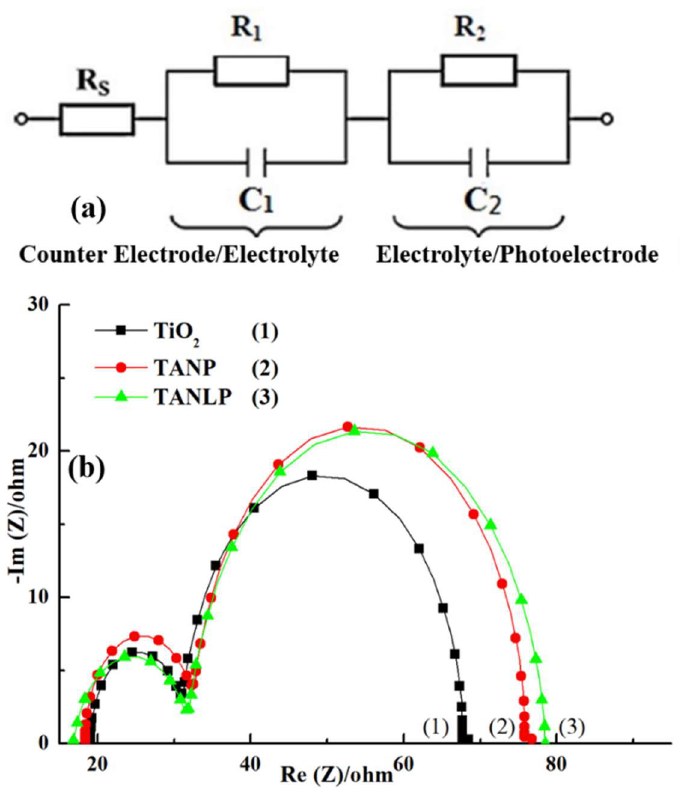
Figure 8. Electrochemical Impedance Spectroscopy of the DSSCs based on different photoelectrodes— ( a ) the equivalent circuit and ( b ) Nyquist plots for DSSCs with different photoelectrodes of the DSSC. The Incident Photon-to-electron Conversion Efficiency (IPCE) is the ratio of the number of electrons collected by a solar cell to the number of photons of a given energy incident on the solar cell. Figure 9 shows the IPCE spectrum of DSSCs with different photoelectrodes with wavelengths from 400 to 800 nm. TANLP has a significant improvement in IPCE.